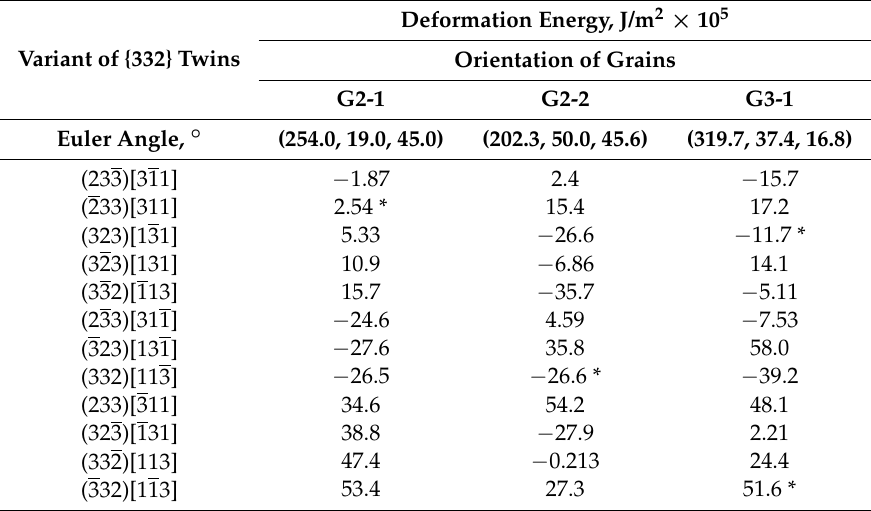
Table 1. Results of the deformation energy for {332}<113>